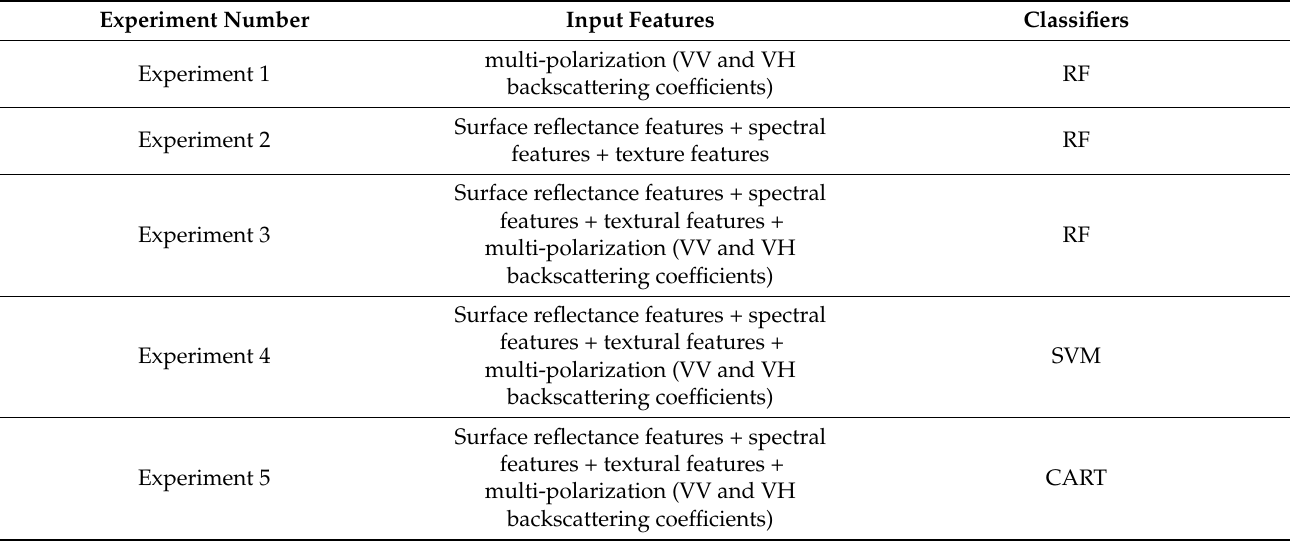
Table 3. Validation experiment.